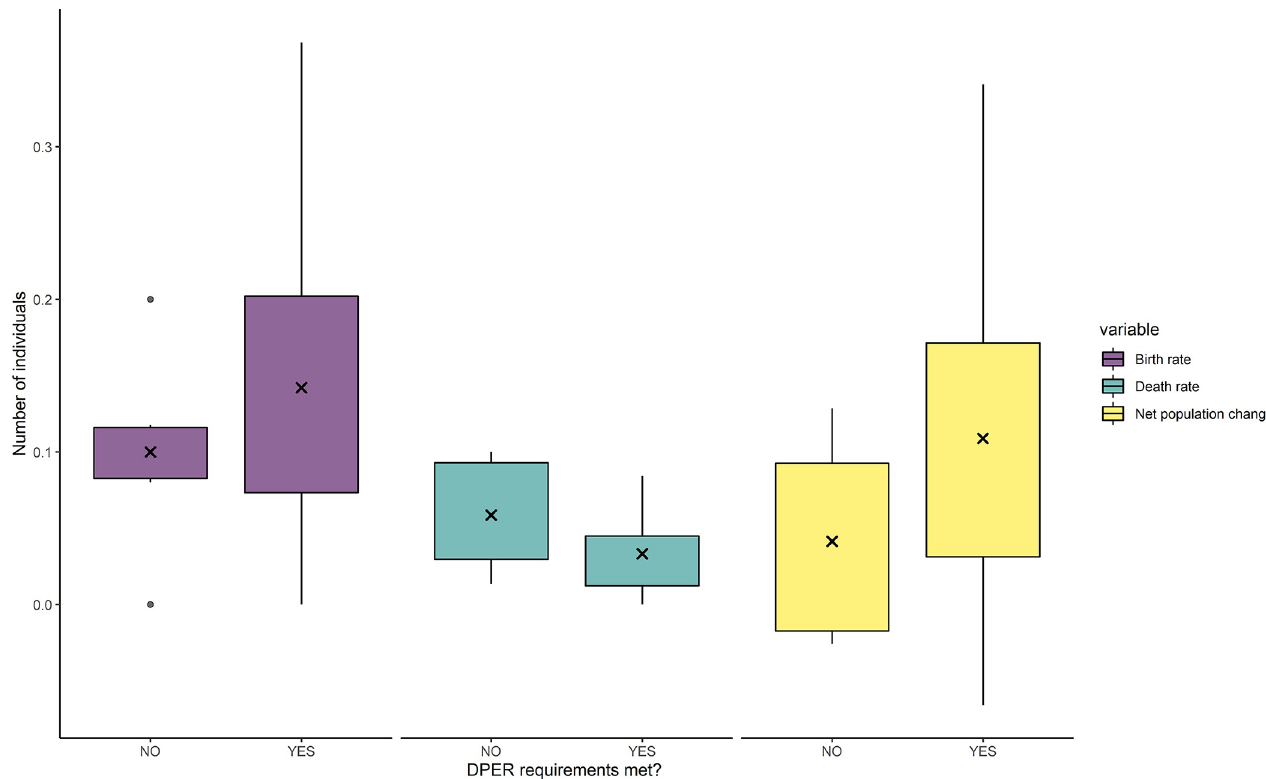
Fig 6. Whisker plot representing the number of births, deaths, and net population growth compared between years where SRKW did not meet their DPER (during at least one season over the year) and years where DPER were met in all seasons. The cross represents the mean.